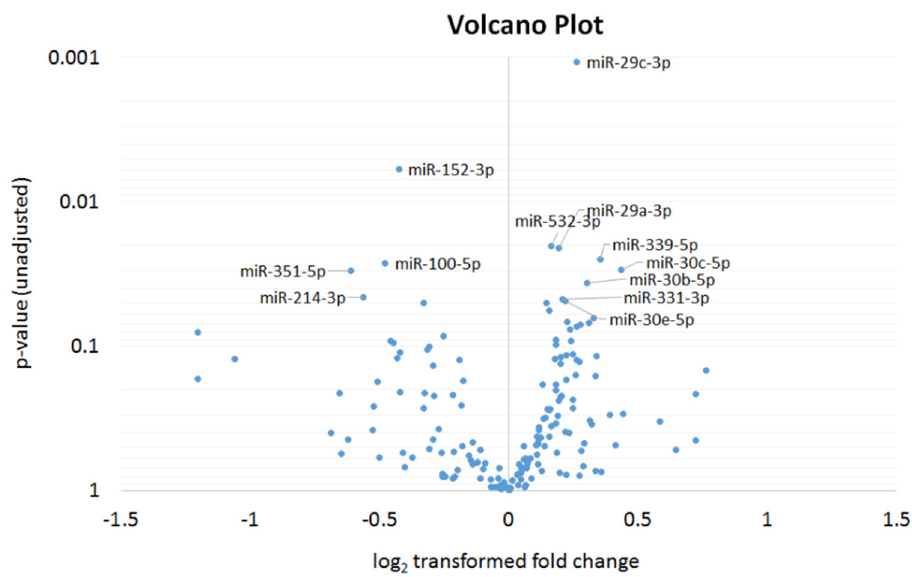
Figure 6. MicroRNA screening. Results of a pairwise comparison of circulating microRNA levels before and after shockwave treatment. Volcano plot shows the relationship between the log2 fold change in 187 microRNAs between treated and untreated animals. All miRNAs with p < 0.05 are labeled. Statistical differences were calculated using a paired two ‐ sided t ‐ test.